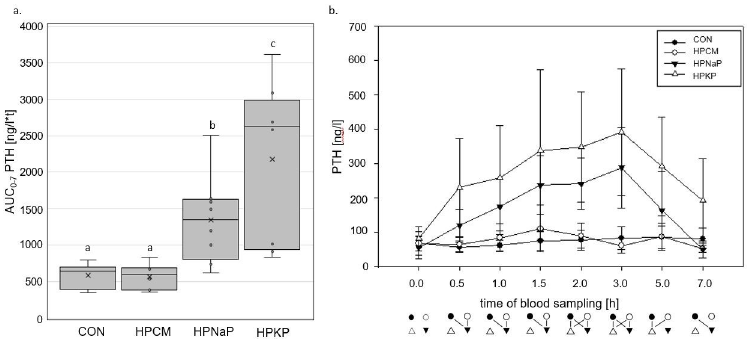
Fig 4. Serum PTH concentrations. a. AUC 0-7 of PTH [ng/l � t] in adult dogs fed a control and 3 different high P diets for 18 days. Boxes not sharing a superscript letter are significantly different (p < 0.05) b. Kinetics from 0 to 7 hours postprandially of PTH [ng/l] in adult dogs fed a control and 3 different high phosphorus diets for 18 days. Connected symbols below the graph are significantly different (p < 0.05) at the corresponding time point. Reference range for healthy adult dogs: 8–45 ng/l (ALOMED